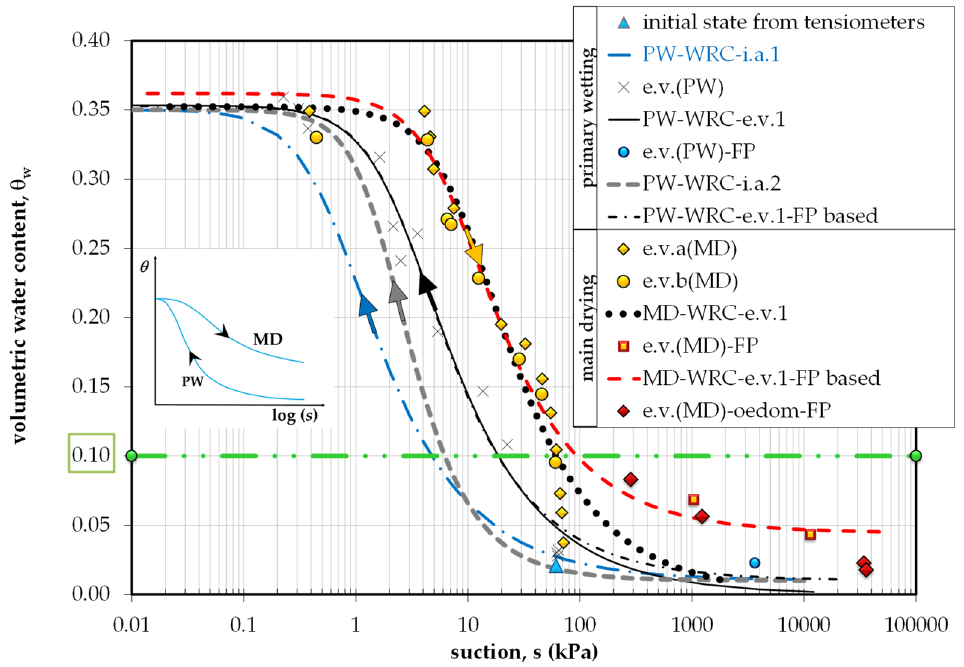
Figure 11. Experimental data from measurements and water retention functions from different estimate approaches. The inner plot shows the assigned hydraulic history.